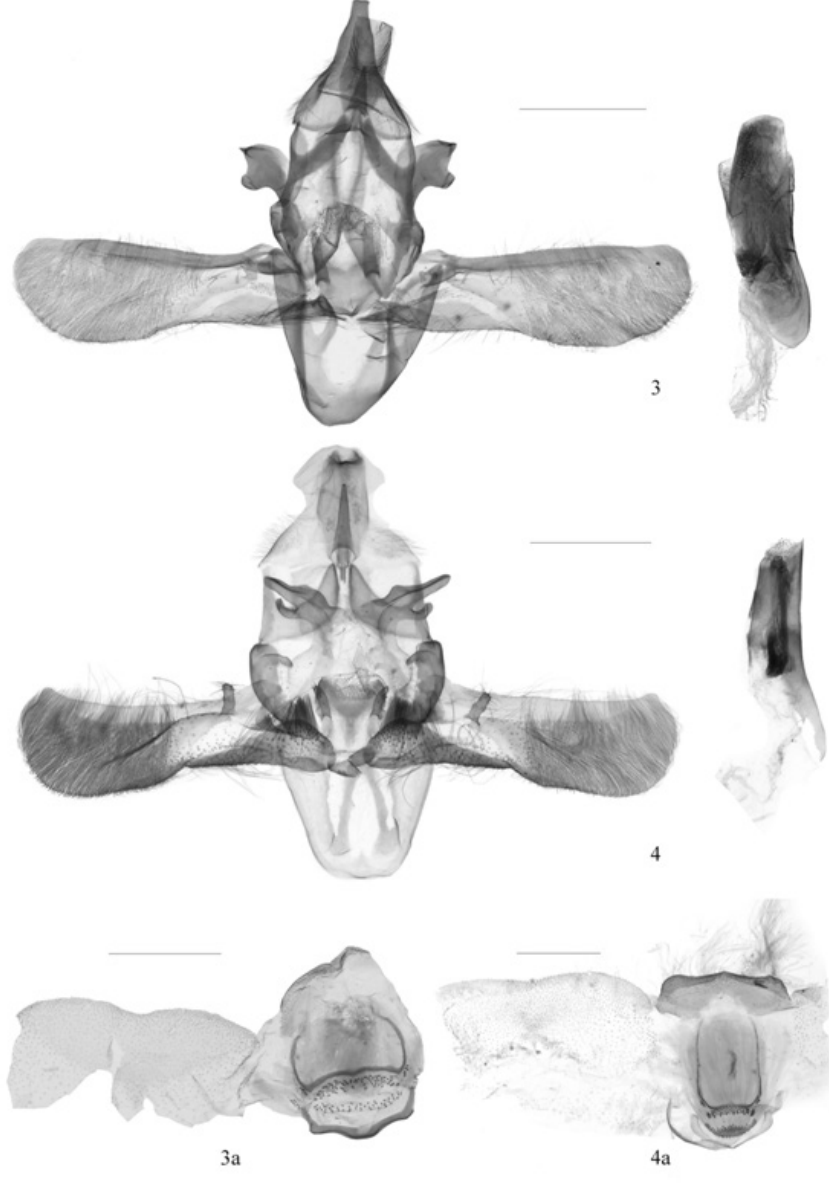
Figures 3−4. Male genitalia structures of Pseudacrobasis species: 3 P . dilatata sp. n. ( 3a culcita), slide No. YLL15176 4 P . tergestella ( 4a culcita), slide No. RYD04497. Scale bars: 0.5 mm. Female genitalia (Fig. 5). Anal papillae subtriangular, narrowed in distal 1/4, rounded at apex. Eighth abdominal segment collar-shaped, approximately 2.5 times wider than long, with tergite arched at middle of anterior margin, slightly